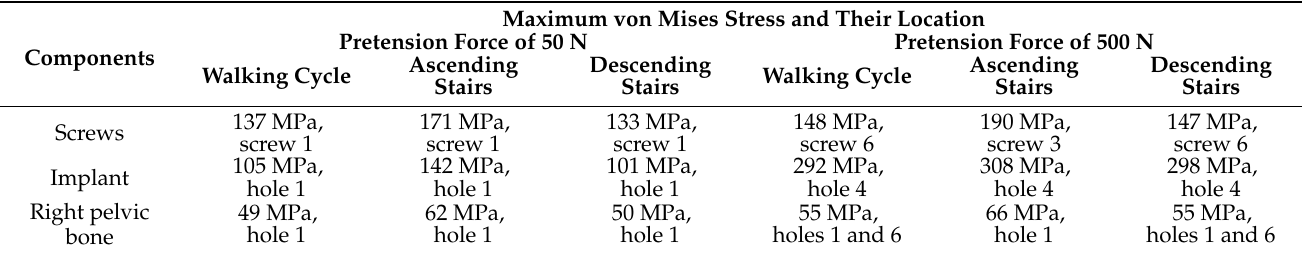
Table 5. Summary of the maximum von Mises stress occurring in the endoprosthesis components and bone tissue for screw pretension loads equal to 50 N and 500